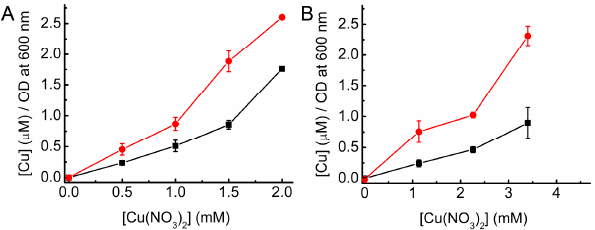
Figure 4. The influence of expressing Bs Csp3 on Cu levels in E. coli . ( A ) The Cu concentration in Δ copA E. coli plus pBAD33_ Bscsp3 (red circles) compared to plasmid ‐ only controls (black squares) grown for 12 h in 0, 0.5, 1.0, 1.5 and 2.0 mM Cu(NO 3 ) 2 . ( B ) Results for WT E. coli plus pBAD33_ Bscsp3 (red circles) and plasmid ‐ only controls (black squares) grown for 12 h in 0, 1.1, 2.3, and 3.4 mM Cu(NO 3 ) 2 (Cu was not quantified in cells at 4.5 mM Cu(NO 3 ) 2 due to the lack of significant growth). Average values and standard deviations from three independent experiments are shown, apart from at 2.0 mM in ( A ) where the amount of Cu was measured once.